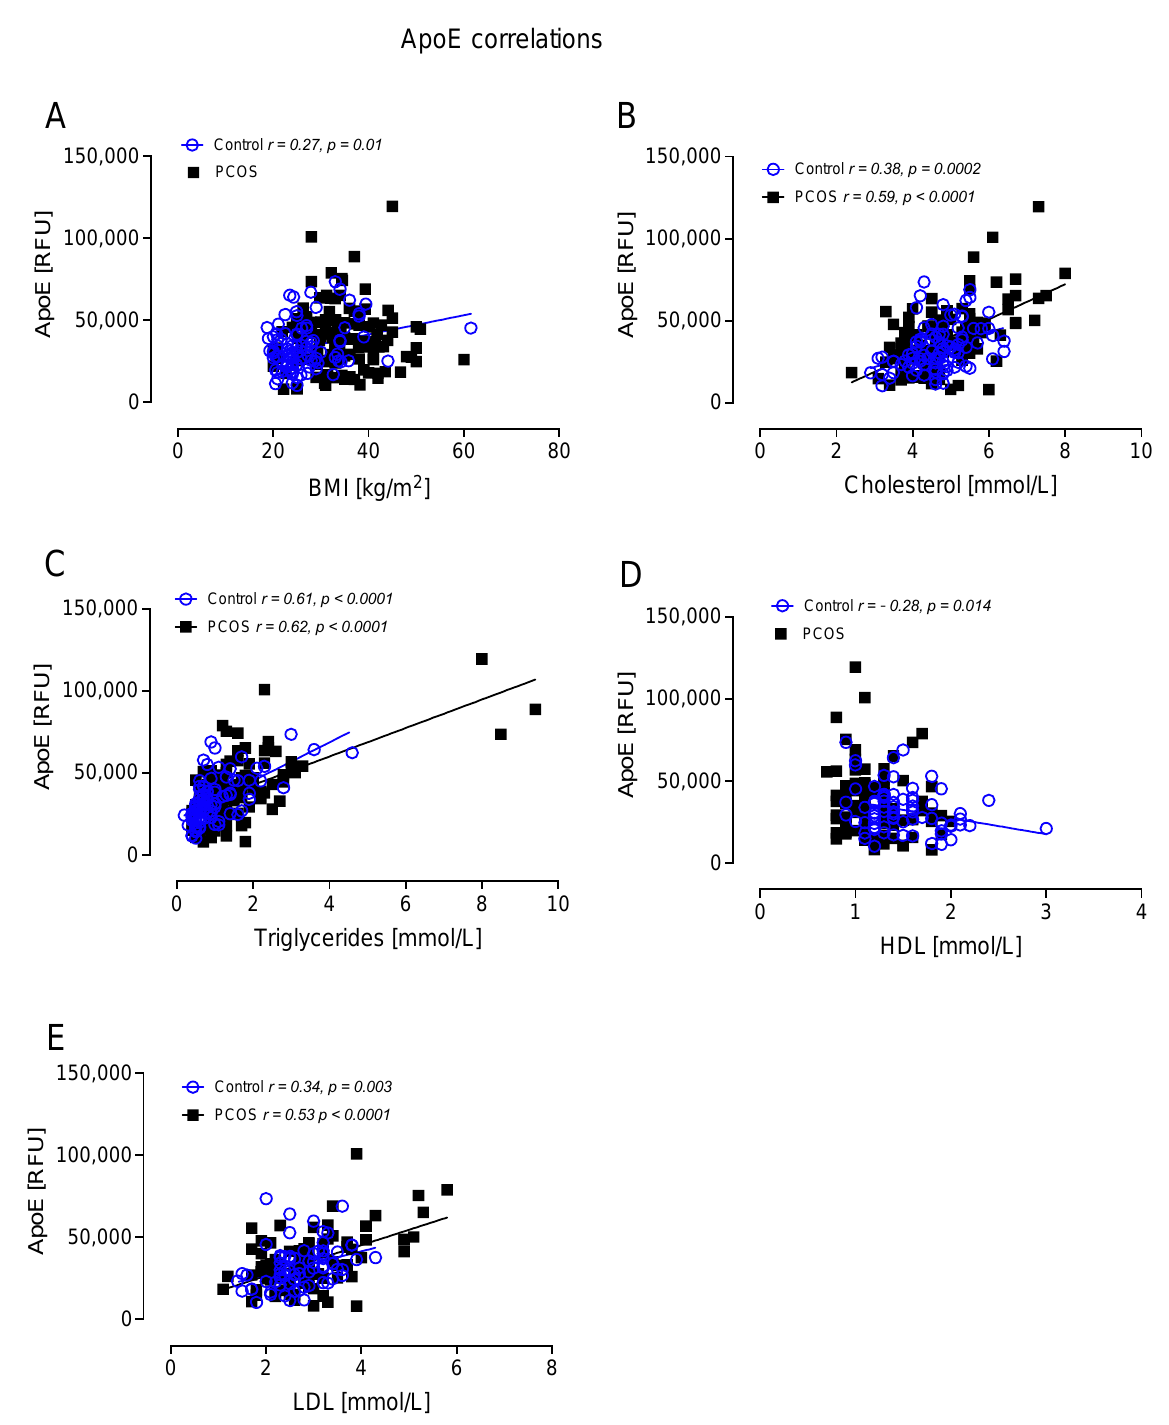
Figure 4. ApoE correlated significantly with BMI in controls ( A ), cholesterol in controls and PCOS ( B ), triglycerides in controls and PCOS ( C ), HDL in controls ( D ), and LDL in controls and PCOS ( E ). ApoM correlated negatively with BMI in controls ( r = −0 .36, p = 0.0004) and PCOS (r = −0 .57, p < 0.0001); correlated negatively with TG in controls ( r = −0 .50, p < 0.0001) and PCOS ( r = −0 .46, p < 0.0001); correlated positively with HDL-C in controls (r = 0.54, p < 0.0001) and PCOS (r = 0.67, p < 0.0001); correlated negatively with CRP in controls (r = −0 .32, p = 0.003) and PCOS ( r = −0 .41, p < 0.0001); and correlated negatively with HOMA-IR in controls ( r = −0 .50, p = 0.007) and PCOS ( r = −0 .45, p = 0.008) (Figure 5).